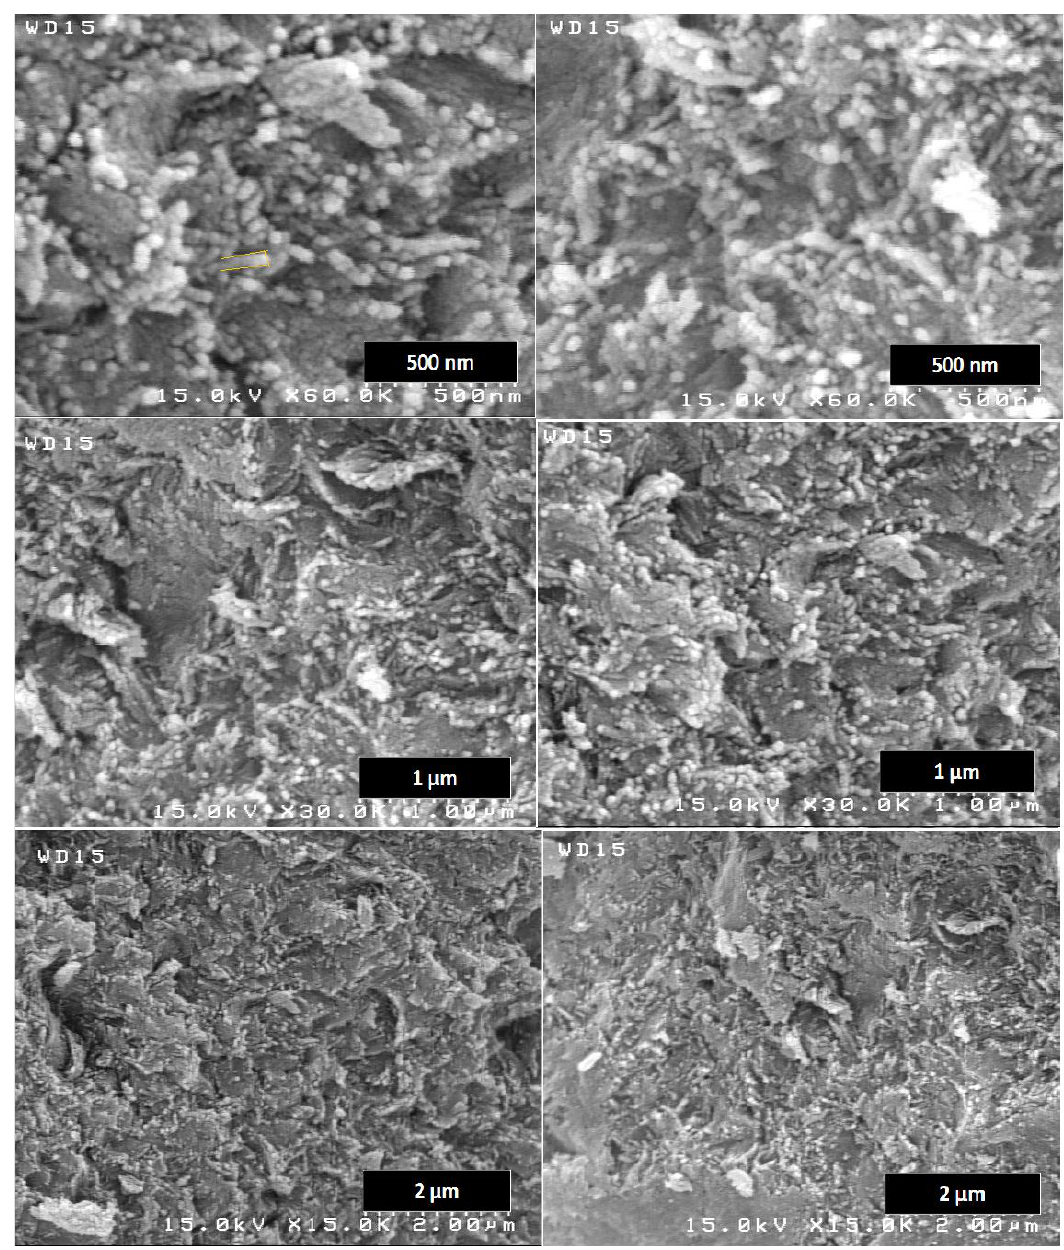
Fig. 5. SEM micrographs of the St-A